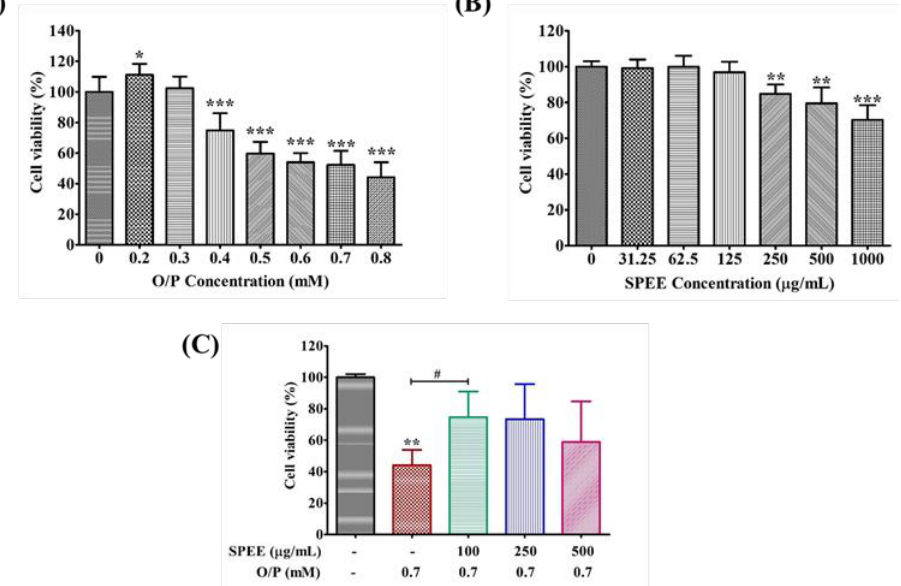
Figure 3. The effects of O/P SPEE and their combined treatments on HepG2 cell proliferation at 24 hr. ( A ) The viability of HepG2 cells. ( B ) The cytotoxicity of SPEE on HepG2 cells. ( C ) The rescue of HepG2 cells treated with O/P 0.7 mM by SPEE within a dose range of 100 to 500 μ g/mL. Data are expressed as mean ± SD from triplicate experiments ( n = 3). The Student ’ s t-test was used to compare the means between two groups. * p < 0.05, ** p < 0.01, *** p < 0.001 vs. the control group. # p < 0.05 vs. the O/P group.